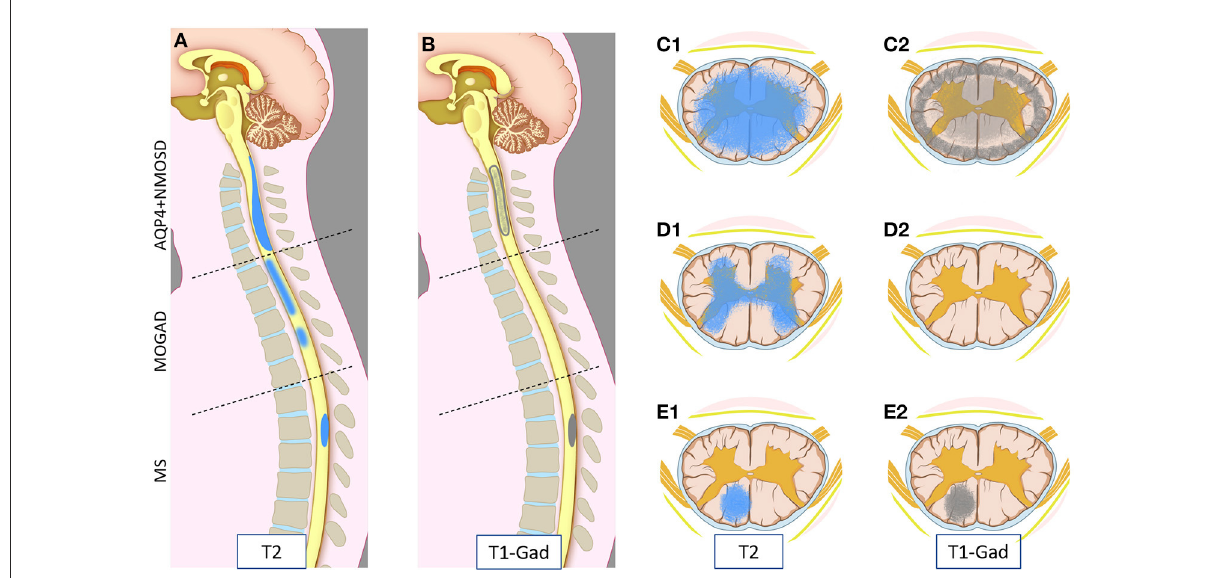
FIGURE1 Schematic representation of myelitis lesion location and gadolinium enhancement patterns on spinal cord MRI in AQP4-IgG-positive neuromyelitis optica spectrum disorder (AQP4 + NMOSD), MOG-IgG associated-disease (MOGAD), and multiple sclerosis (MS). Sagittal T2 (A) and T1 post-gadolinium (B) MRI images (left half); and axial T2 (C1,D1,E1) and T1 post-gadolinium (C2,D2,E2) images (right half) are schematically represented. Patients with AQP4 + NMOSD myelitis typically show a single longitudinally extensive lesion in the cervical spinal cord [ (A) upper part] with extensive parenchymal involvement axially (C1) on T2 weighted sequences. These lesions typically show gadolinium enhancement during attacks, often at the periphery of the T2 lesion with a ring-like pattern axially (C2) or “elongated ring” when appreciated on sagittal images [ (B) upper part]. In MOGAD, myelitis lesions can affect any spinal cord level with similar frequency. Short and longer T2-lesions can coexist (not shown) [ (A) central part]; while acute lesion enhancement is absent in ∼ 50% of cases [ (B) central part, (D2) ] and when present is often nonspecific. On axial images, T2 abnormalities often predominantly involve the central gray matter (H-sign) (D1) . Lastly, MS myelitis lesions are typically short on sagittal T2 images [ (A) bottom part], often showing ring or nodular/ovoid enhancement during acute attacks [ (B) bottom part, (E2) ]. On axial images, T2 lesions typically affect the periphery of the spinal cord along the dorsal or lateral columns that clinically results in a “partial transverse myelitis” (E1) . All three diseases can involve the entire spinal cord, and different lesion locations in this figure are intended for graphic